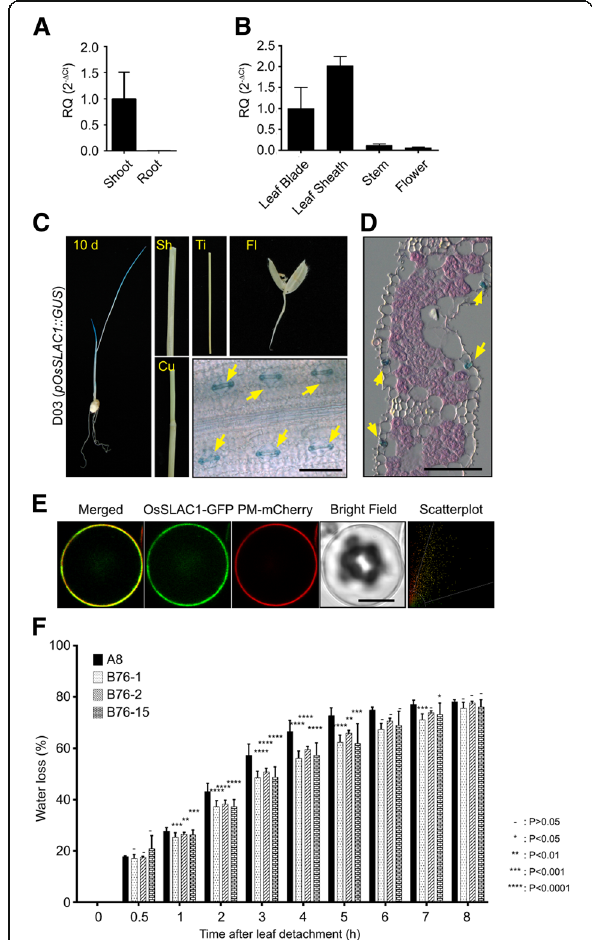
Fig. 1 OsSLAC1 is specifically expressed in rice guard cells and OsSLAC1-GFP localizes to the plasma membrane in rice protoplasts. a RT-qPCR analysis of OsSLAC1 gene expression in two-week-old seedlings. The generated RQ (relative quantity, 2 - Δ Ct ) was compared to the value of expression on shoot. OsUbi5 was used as endogenous control. The values depict the average and ± SD with 3 replications. b RT-qPCR analysis of OsSLAC1 gene expression in different tissues of mature rice (80 days old). The values were compared to the expression level on leaf blade. c Histochemical β -glucuronidase analysis of OsSLAC1 promoter-GUS transgenic rice. Left image is a 10-day-old seedling. Sh (sheath), Ti (tiller), Fl (flower), Cu (culm) and leaf blade epidermis (bottom right). Scale bars are 50 μ m. d A section of paraffin-embedded leaf blade stained with X-Gluc (blue) and eocin. Yellow arrows indicate guard cells. Scale bars are 50 μ m. e Subcellular localization of OsSLAC1-GFP and marker protein in rice protoplast. PM-mCherry is a plasma membrane localization marker. The scatterplot shows the values of fluorescence of the pixels across the two channels. Scale bars are 10 μ m. f Water loss assays of OsSALC1 -overexpressing transgenic lines (B76 – 1, 2 and 15) and control line (A8: empty vector transgenic plant). The values depict the average and ± SD with 3